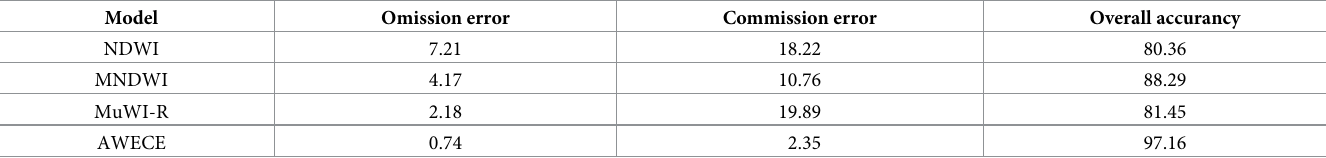
Table 4. The accuracy of different water extraction models.